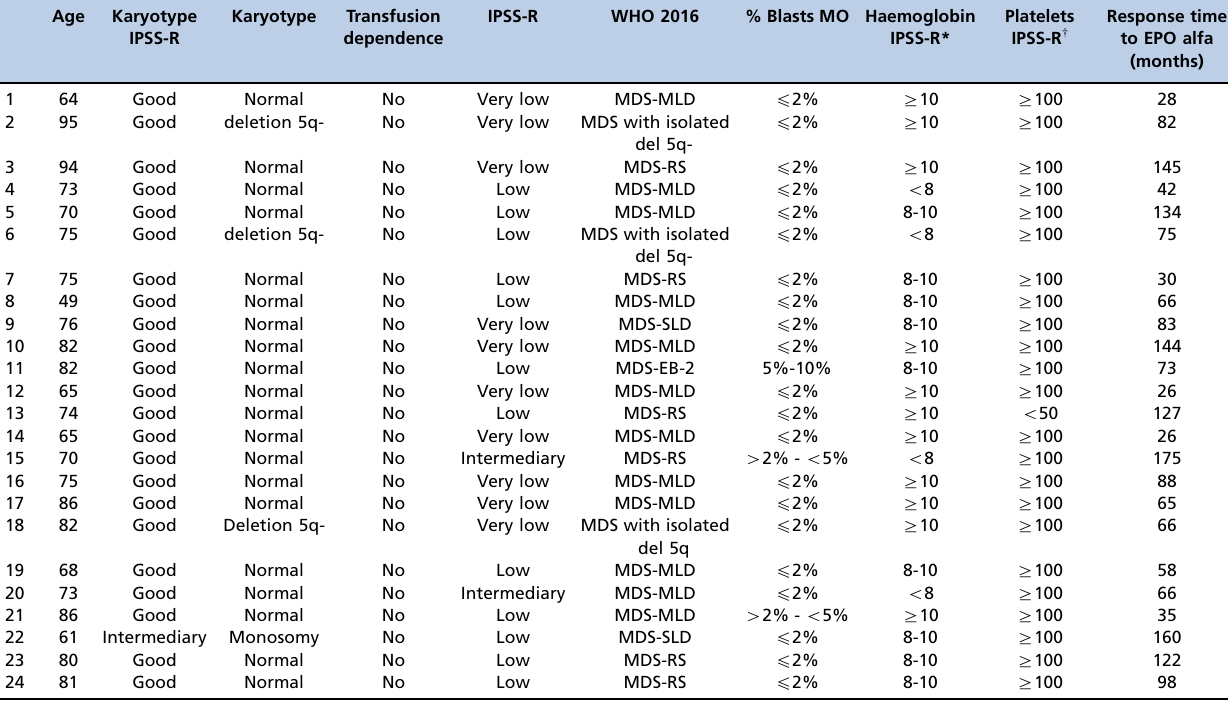
Figure 3 - The mean haemoglobin of the population studied during treatment with EPO alfa. Table 2 - Patients with a response of greater than 24 months (25 to 175 months,